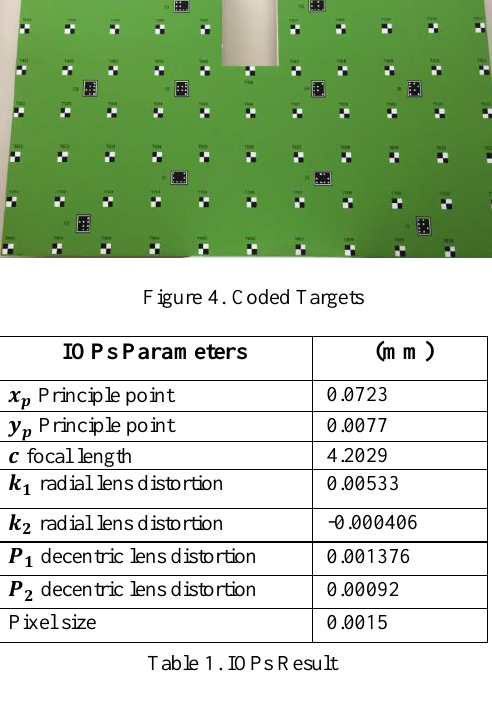
Figure 5. Collinearity Equation